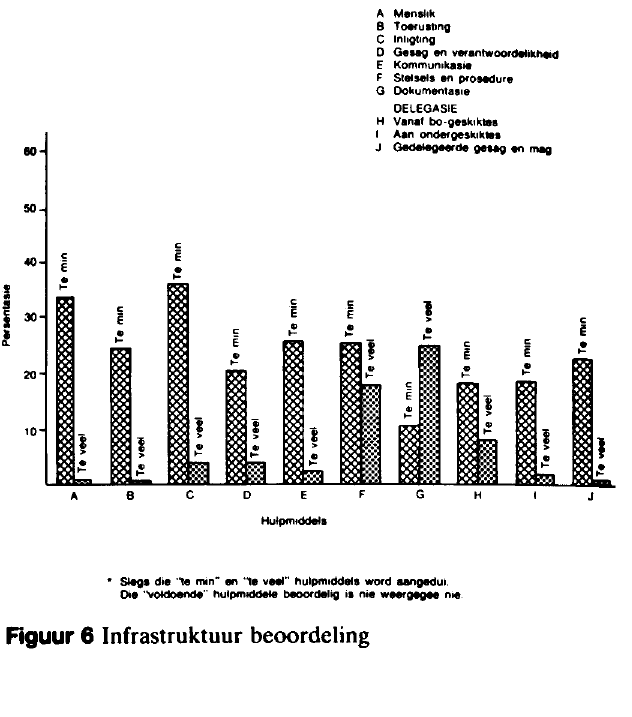
het hy bepaalde hulpmiddele nodig in die vorm van menslike ondersteuning, voldoende inligting, gesag en verantwoordelikheid, en veral kommunikasie. Indien dit waar is dat optimale bestuursbenutting van die infrastruktuur afhang, hoe lyk die infrastruktuur dan wat ondernemings aan hul bestuur beskikbaar stel? Vergelyk Figuur 6 vir terugvoer in hierdie verband. In die bree beskou, is bestuur, tot 34,8%, van oordeel dat hulle te min menslike hulpbronne tot hul beskikking het en 36, 1 % stel dat hulle te min inligting ontvang.